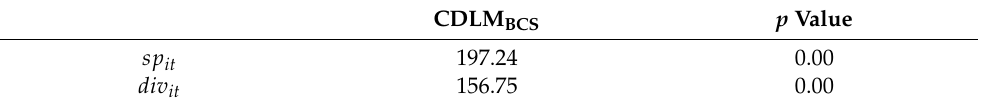
Table 2. Baltagi et al. (2012) bias-corrected scaled LM test of cross-section dependence.